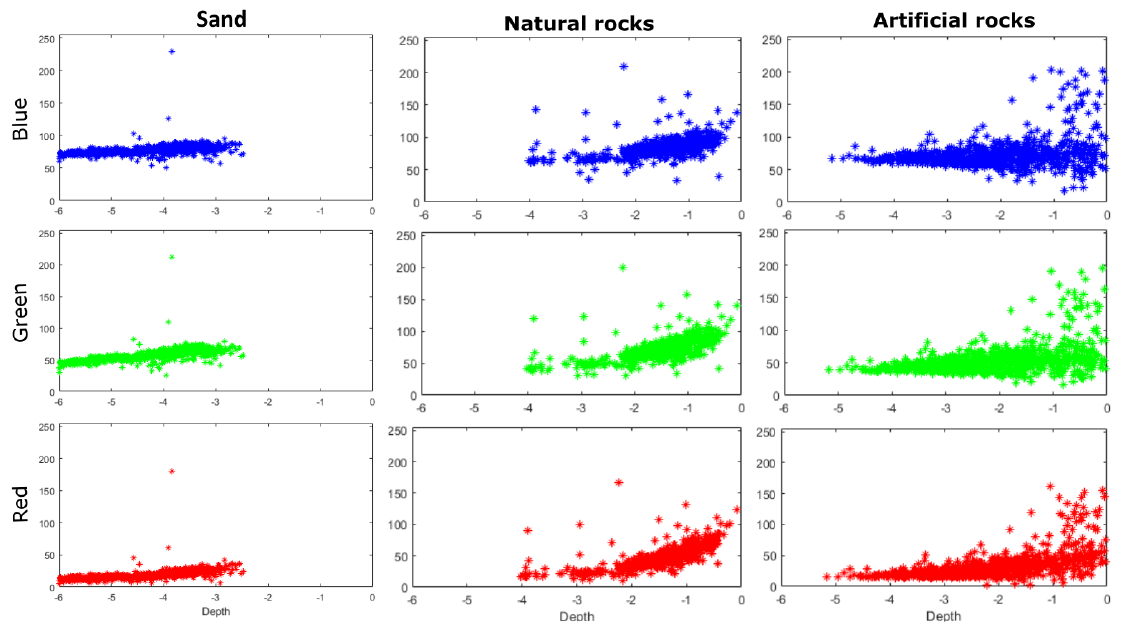
Figure 15. RGB/depth plots, showing the relationship of the value of the three RGB bands versus the depth of the GPs for sand, natural and artificial rocks classes of the aircraft orthophoto. Portosole overlap area.